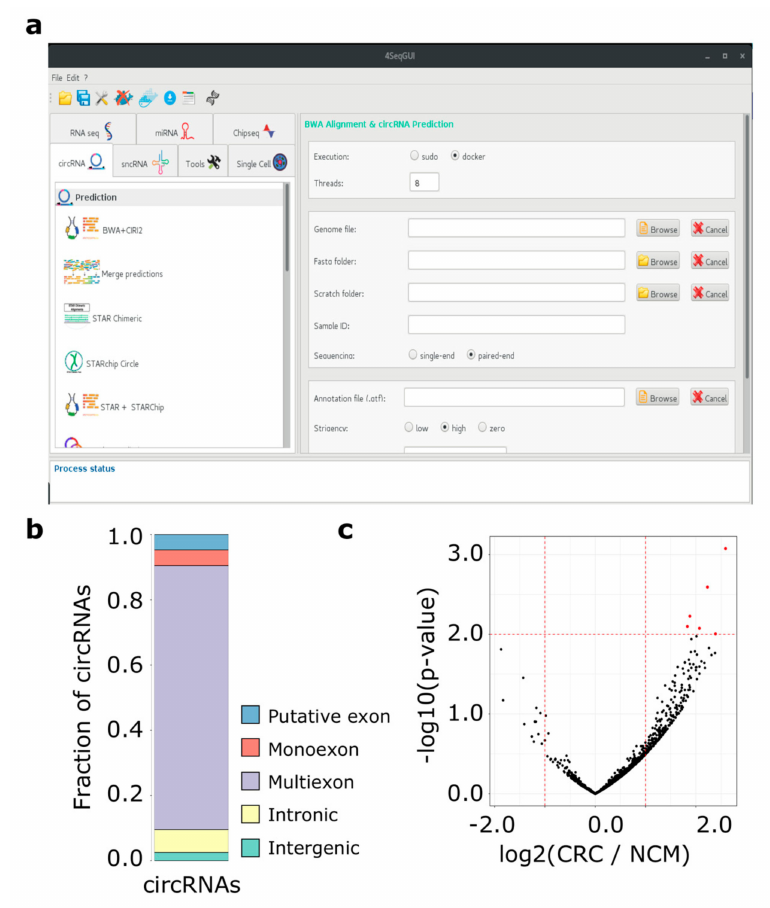
Figure 2. ( a ) The Docker4Circ Graphical User Interface. Each module implemented in the framework is accessible using the panel on the left, the right panel reports the fields and parameters of each function; ( b ) Bar plot reporting the Docker4Circ classification of circRNAs identified in the analysis of RNA-Seq datasets from CRC cell lines; ( c ) Volcano plot reporting the -log10 p-value and the log2 expression fold change (red dashed lines) computed between Docker4Circ counts of BS supporting reads from RNA-Seq datasets of NCM and CRC tissue